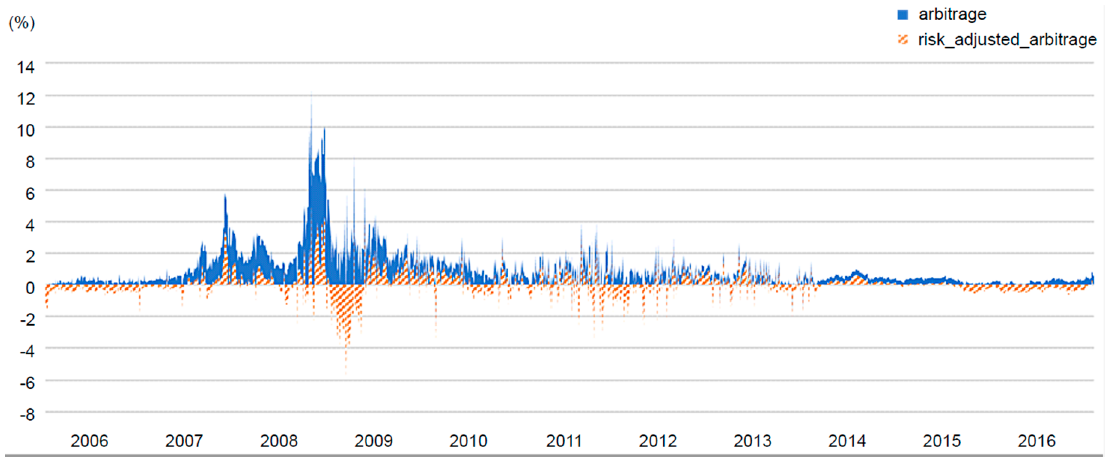
Figure A1. Original versus risk-adjusted arbitrage opportunities. Source: Author’s calculation using Bloomberg and Bank of Korea (BOK) databases.